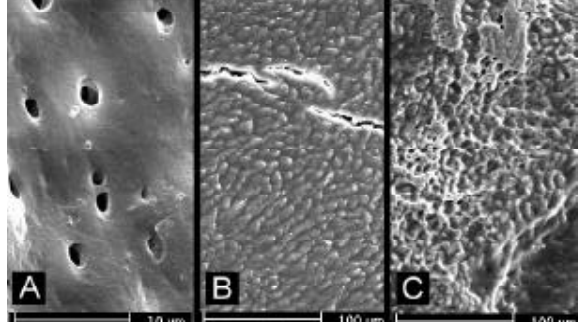
FIGURA 6- grupo 4 – dentes instrumentados e condicionados com ácido cítrico: A – ausência de smear layer e túbulos dentinários desobstruídos (aumento 2500X); B – smear layer removidos e fibras colágenas à mostra